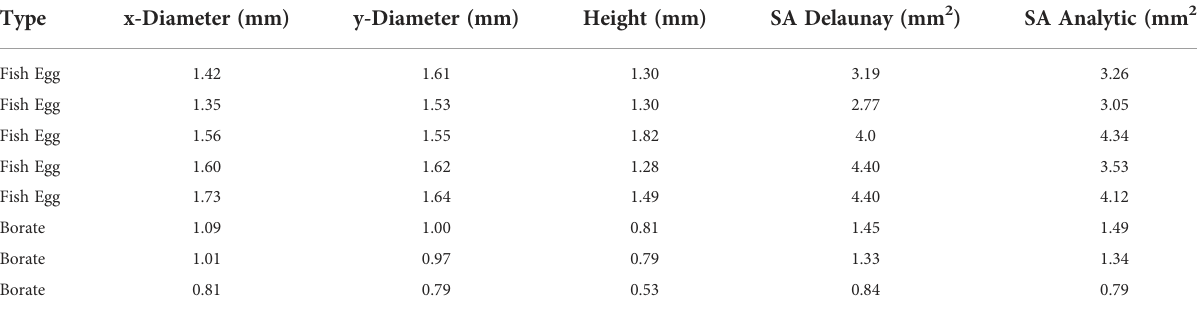
TABLE 2 Surface areas of borate spheres and fi sh eggs as determined from OCT scans and from independent size measurements.